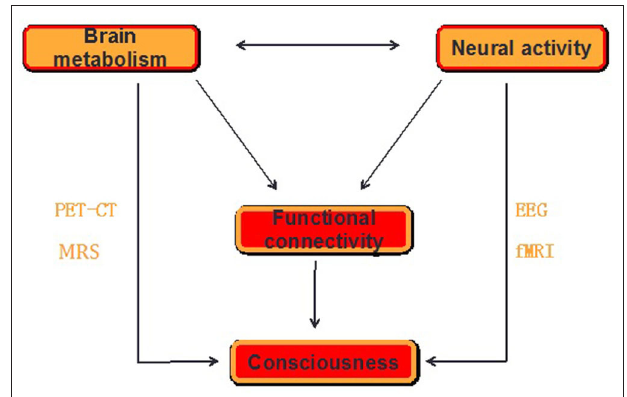
FIGURE 1 | The schematics for the proposed mechanism of consciousness. Consciousness requires a form of neural activity that is metabolically expensive while the loss of consciousness is related to an uncoupling between the neural activity and brain energy, which can be measured by functional neuroimaging [PET-CT and functional MRI (fMRI)] and neurophysiological [electroencephalogram (EEG)] and neurochemical [magnetic resonance spectrum (MRS)] techniques in the form of functional connectivity (FC) within and between the brain regions. The pattern of FC is believed to be related to the level of